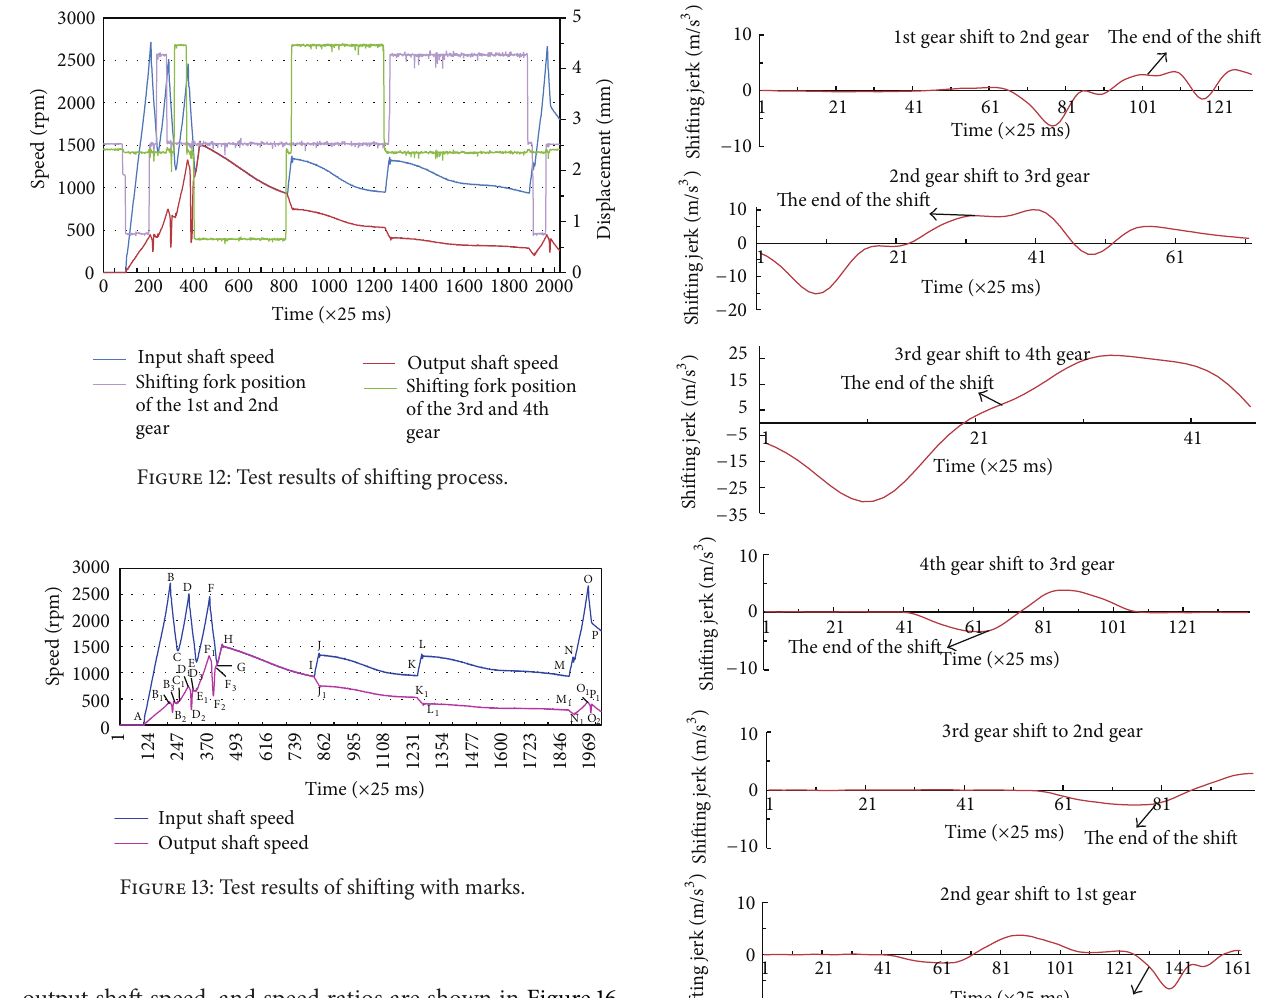
Figure 14: The test results of shifting jerk.